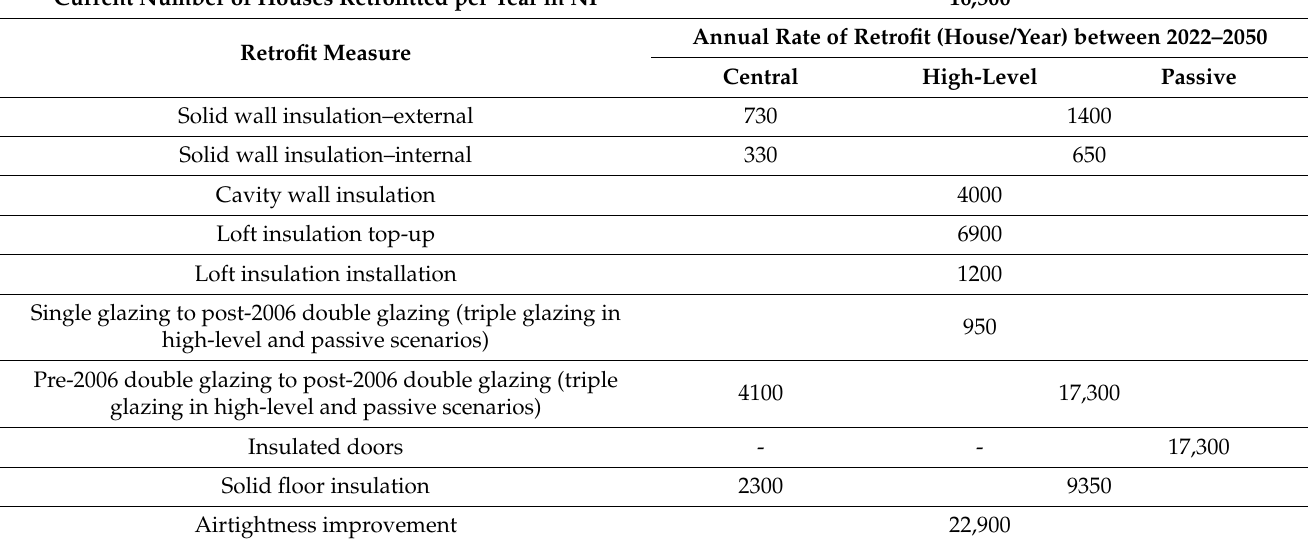
Table 4. Comparison between current number of houses retrofitted per year in NI and the annual rate of retrofit (house/year) for each measure if all scenarios were evenly implemented between 2022 and